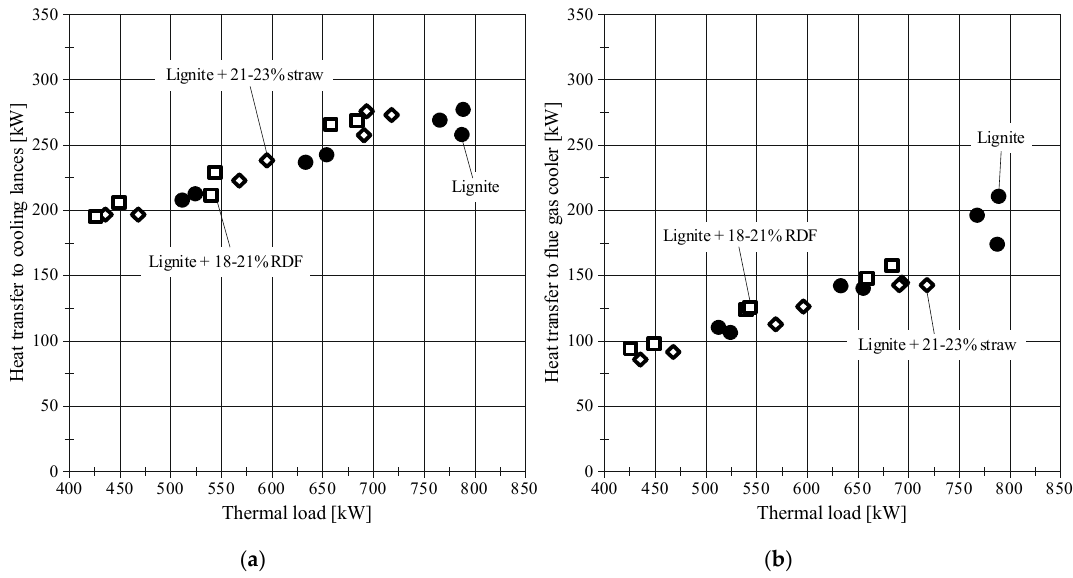
known that the heat transfer coefficient for particle convection is highly dependent on the